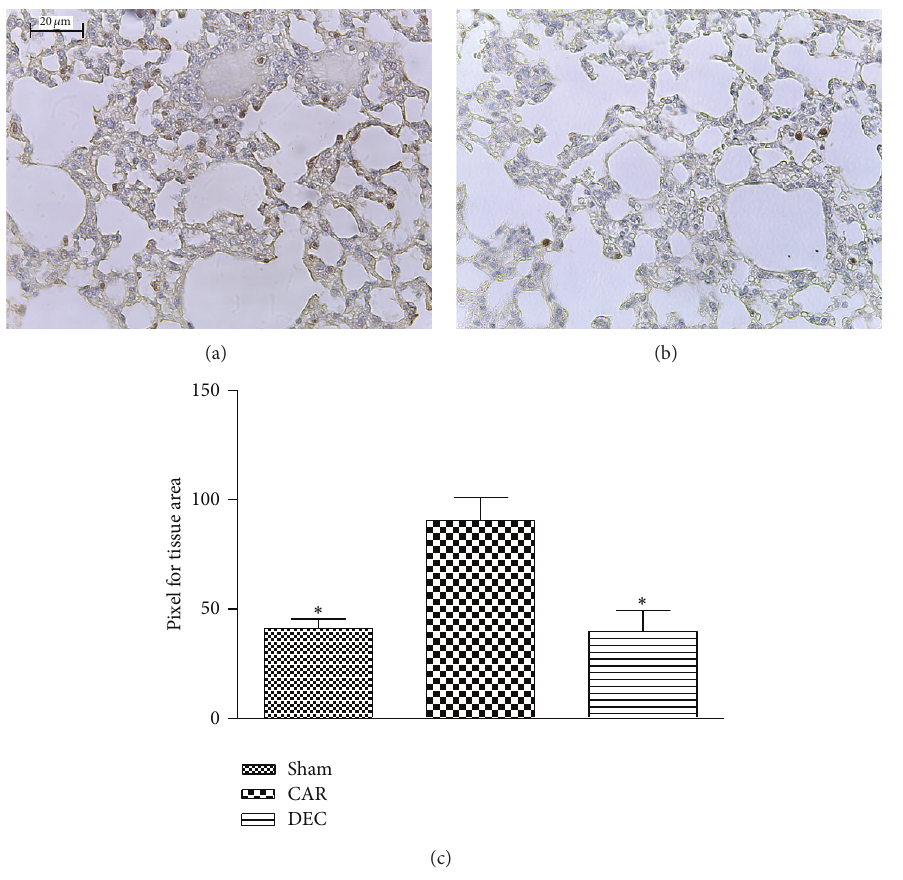
Figure 8: Effect of DEC on immunohistochemical localization of iNOS in lung tissue after pleurisy induced by carrageenan. (a) In tissue sectionsfromtheCARgroup,positivelabelingwasdetectedonalveolarmacrophages.(b)TreatmentwithDECsignificantlyreducedtheiNOS staining in comparison to the CAR group, achieving levels similar to the sham group. (c) Densitometry analysis of immunohistochemistry photographs for iNOS from lung tissues; figure representative of at least 3 experiments performed on different experimental days; data expressed as mean ± S.E.M. from 𝑛 = 5 mice for each group; ∗ 𝑃 < 0.05 versus carrageenan; scale bar = 20 𝜇 m.